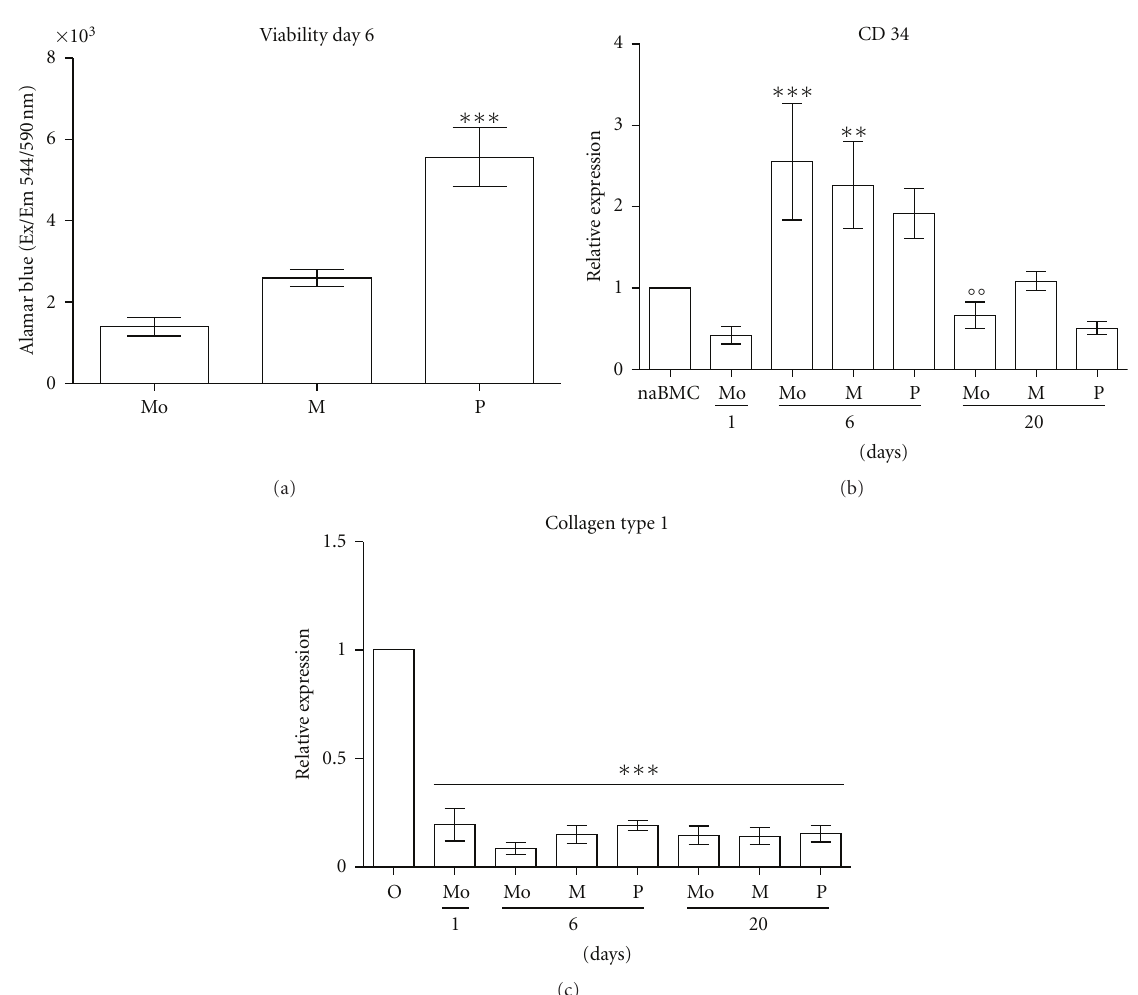
Figure 1: Treatments to obtain PCMOs and MOMPs influence proliferation and expression of monocytes. (a) Human mononuclear cells ( N = 4, n = 3) were cultivated without specific treatment (Mo), treated for 6 days to obtain MOMPs (M) or PCMOs (P). Viability was measured by Alamar blue assay on day 6. P shows a significantly higher viability than Mo ( ∗∗∗ P < 0 . 001). (b) Relative expression levels of CD34 measured by RT-PCR normalized to GAPDH and subsequently to expression of CD34 in nonadherent bone marrow cells (naBMCs) as internal control ( N = 3, n = 3). Mo and M show a significantly higher expression of CD34 on day 6 than Mo on day 1 ( ∗∗ P < 0 . 01; ∗∗∗ P < 0 . 001). After osteogenic di ff erentiation, CD34 levels in Mo decreased significantly in comparison to Mo on day 6 ( ◦◦ P < 0 . 05). (c) Relative expression levels of collagen type 1 measured by RT-PCR normalized to GAPDH and subsequently to expression of collagen type 1 in primary osteoblasts (O) as internal control ( N = 3, n = 3). Mo, M and P show expression of low levels of collagen type 1 on all days ( ∗∗∗ P < 0 . 001). Monocytes (Mo) day 1: freshly isolated monocytes; Mo, MOMP (M), and PCMO (P) day 6: cells after treatment; Mo, M, P day 20: cells after di ff erentiation with vitamin D containing medium.